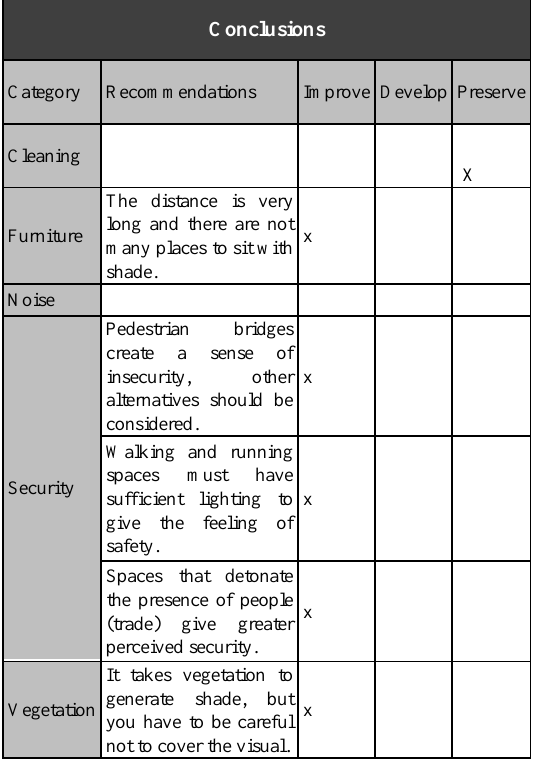
Table 3. Conclusions on crossover